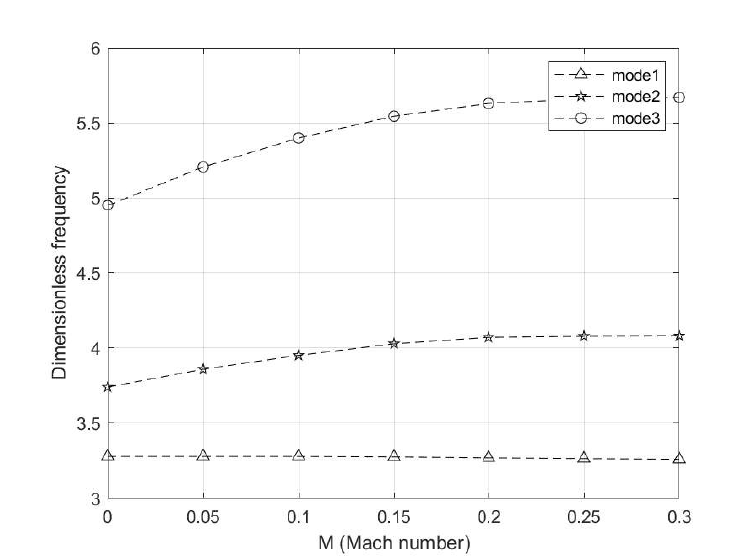
Figure 6. The evolution of the frequency of the first trapped mode with the Mach